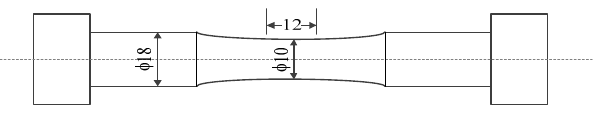
Figure 8. The configuration of the 316 stainless steel specimen.